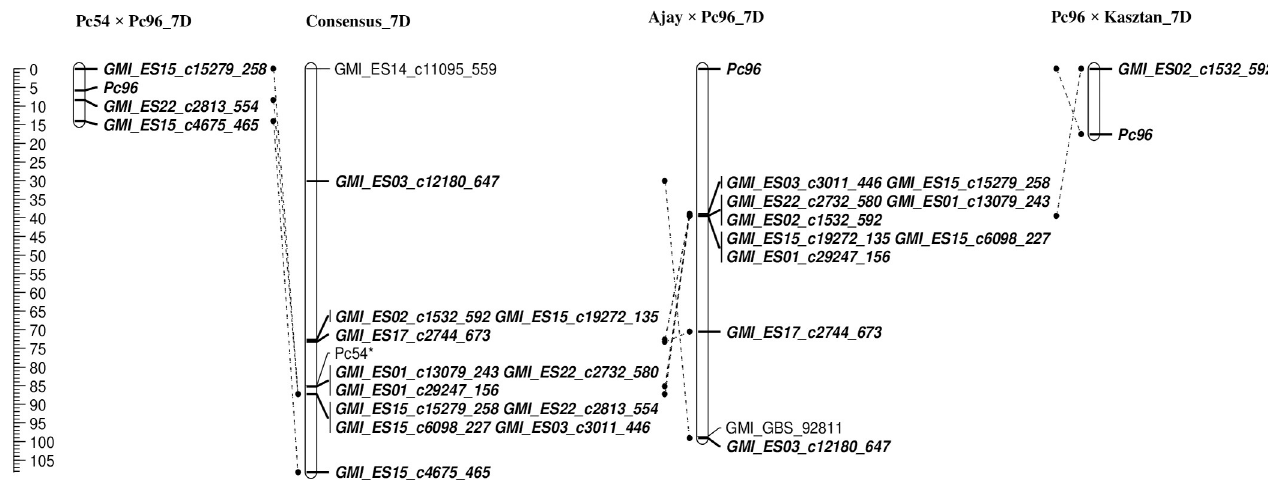
Fig 2. Linkage maps showing the location of the Pc96 crown rust resistance gene. “Consensus Map” refers to the chromosome 7D consensus genetic map of Chaffin et al. [46]. The ruler scale on the left indicates map distances in centiMorgans (cM). * The estimated position of Pc54 on consensus map [19].